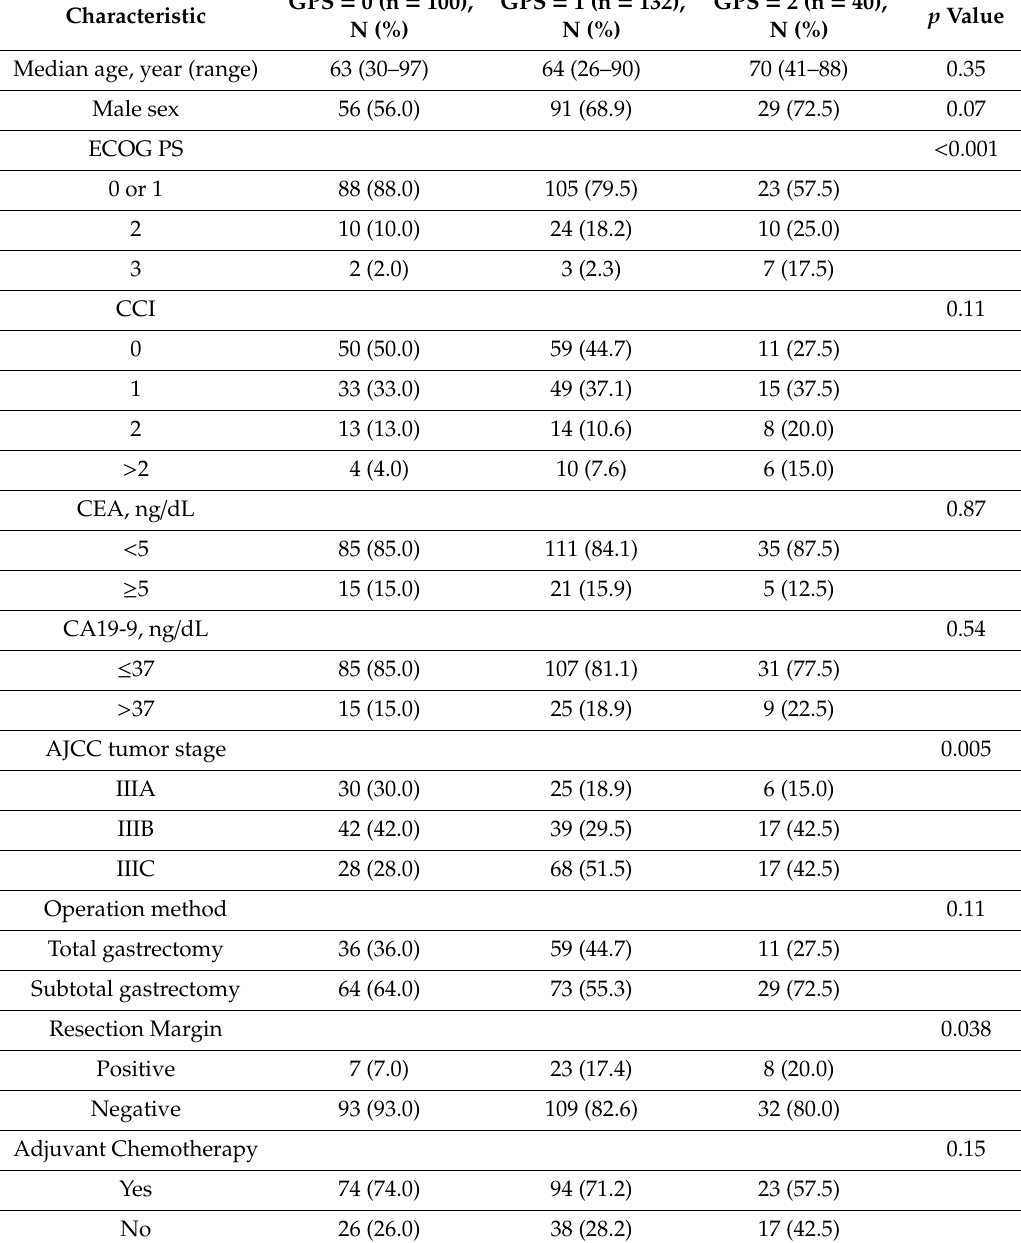
Table 1. Clinicopathological characteristics of patients grouped according to Glasgow prognostic score